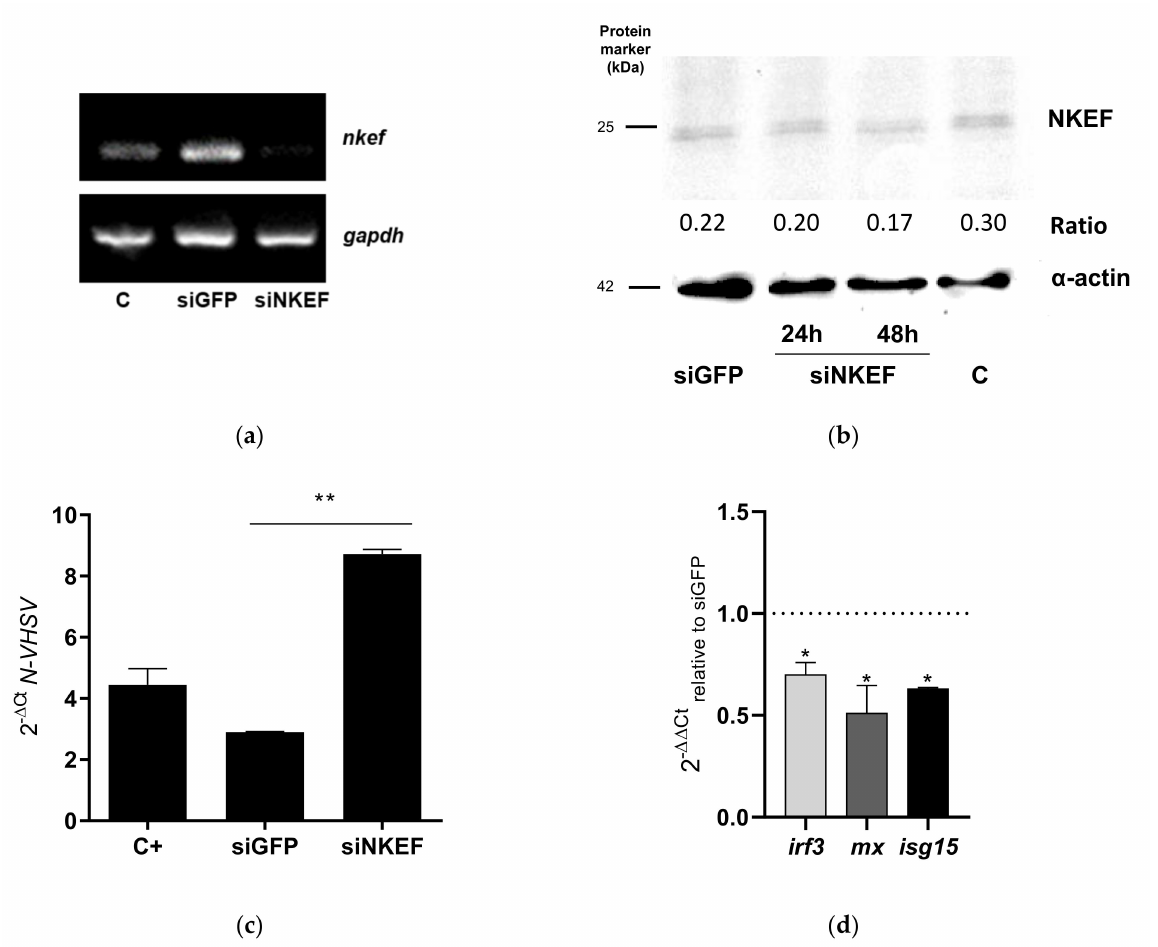
Figure 3. The effect of NKEF gene silencing on VHSV replication in RTG-2. ( a ) RTG-2 cells were electroporated with siNKEF sequences. nkef gene expression was evaluated by RT-PCR after 24 h. siGFP was used as a negative control, and gapdh was used as endogenous control genes. ( b ) Representative image of Western blot of NKEF protein levels after NKEF gene silencing in RTG-2 cells after 24 and 48 h using anti-NKEF antibody. siGFP was used as negative control. C indicates electroporated control cells, and h means hours. The endogenous protein control was α -actin, detected using anti- α -actin antibody. Ratio represents expression of NKEF relative to α -actin expression. ( c ) RTG-2 cells were transfected with siNKEF and after 48 h they were exposed to VHSV MOI 0.1 for 24 h at 14 ◦ C. siGFP was used as negative control. VHSV replication was evaluated by N-VHSV gene expression by RT-qPCR. N-VHSV gene expression. Om-ef1 α was used as the endogenous control gene. C+ means RTG-2 mock electroporated and exposed to VHSV. Data represent the mean ± SD of two experiments. The Kruskal–Wallis test and Dunn’s multiple comparison post hoc test were performed. ** indicates p -value < 0.01. ( d ) Analysis of IFN1 pathway modulation by RT-qPCR of irf3 , mx and isg15 genes in RTG-2 silenced with siNKEF and exposed to VHSV. Bars represent the expression of irf3 (light grey), mx (dark grey) and isg15 (black). Gene expression was normalized to cells transfected with siGFP and infected with VHSV, dashed line. The endogenous gene control used was om-ef1 α . Data represent the mean ± SD of 2 experiments. A Mann–Whitney test was performed for statistical analysis between siGFP and siNKEF transfected cells and infected with VHSV. * indicates p -value <